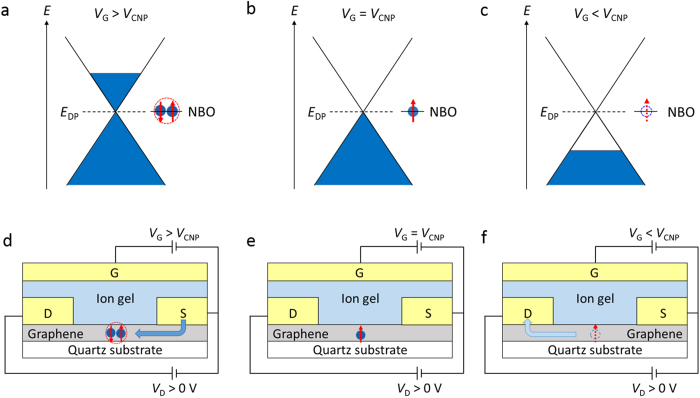
Energy diagram and spin states in the graphene transistor.(a–c) Schematics of the energy diagram and non-bonding orbital (NBO) of graphene with spin states for VG > VCNP (a), at VG = VCNP (b), and for VG < VCNP (c). The energy level of the NBO is located at the energy of the Dirac point (EDP). (d–f) Schematics of the spin states in the graphene transistor for VG > VCNP (d), at VG = VCNP (e), and for VG < VCNP (f).